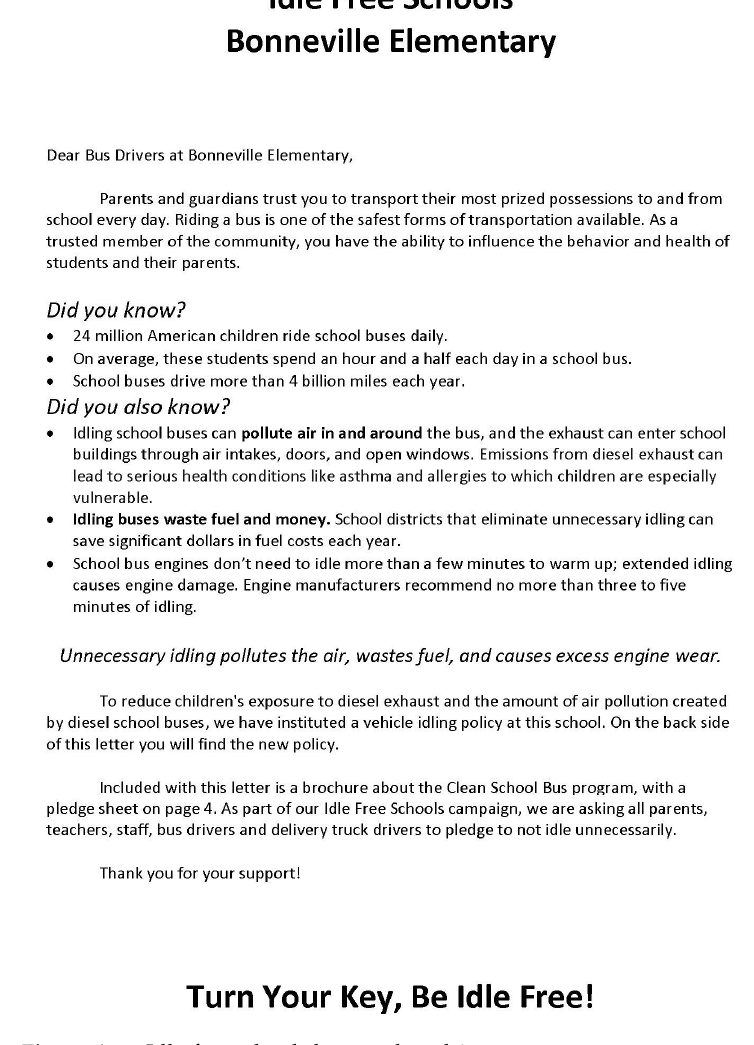
Figure A12. Idle-free schools letter to bus drivers.